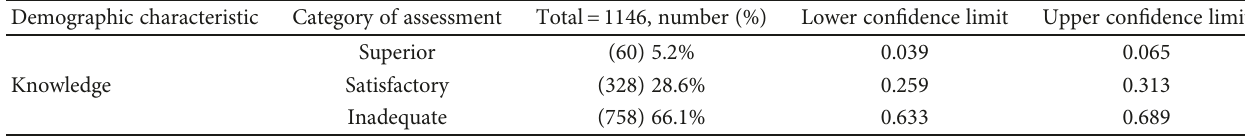
Table 2: Overall subjective knowledge